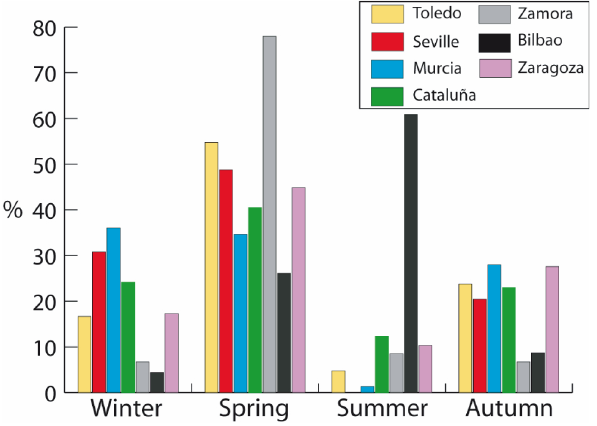
Table 4. Conditional probability of rogation celebration when a rogation has been celebrated in